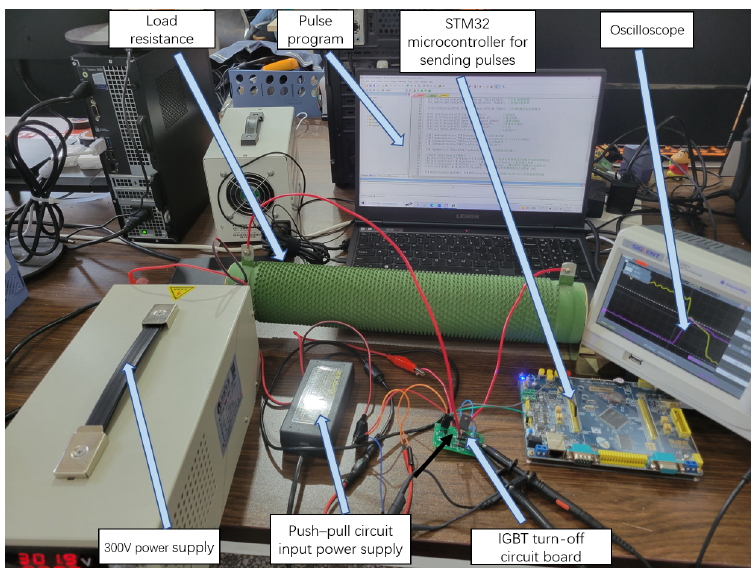
Figure 13. IGBT turn-off